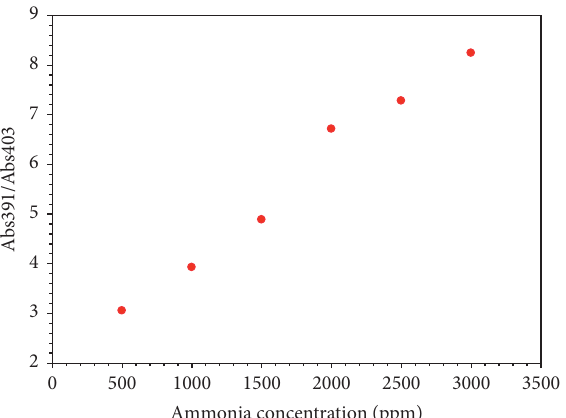
Figure 4: Absorbance ratio at 391nm and 403nm, which displays a linear relationship as a function of different ammonia concentrations (500 ppm to 3000ppm) with a correlation factor R 2 equal to